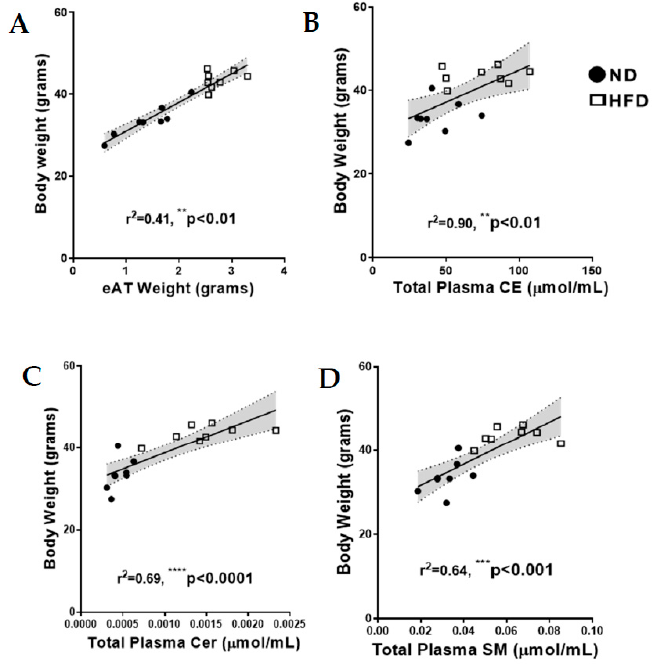
Figure 1. High-fat diet (HFD)-fed mice ( A ) weighed significantly more and showed ( B ) heavier epididymal adipose tissue (eAT) than normal diet (ND)-fed mice. HFD mice also showed elevated total fasting plasma ( C ) cholesteryl ester (CE), ( D ) ceramide (Cer) and ( E ) sphingomyelin (SM) levels. Mouse weight and eAT are expressed as means ± SD and all total lipid data are expressed as means ± SEM. ** p < 0.01, *** p < 0.001, **** p < 0.0001. Asterisks indicate a significant difference compared to the matched ND value.